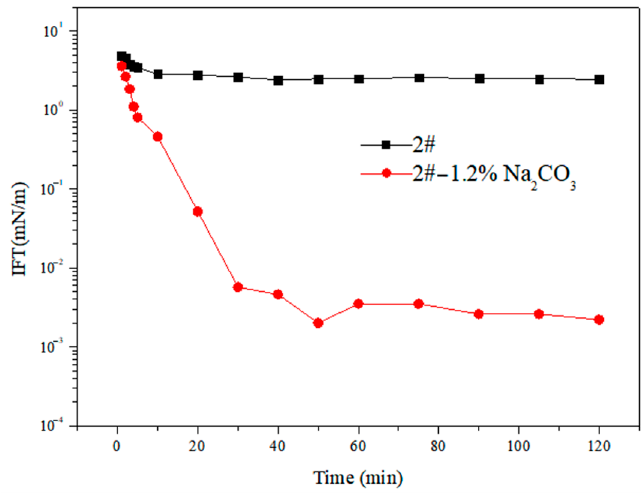
Figure 2. Effect of alkali on interfacial tension over time.